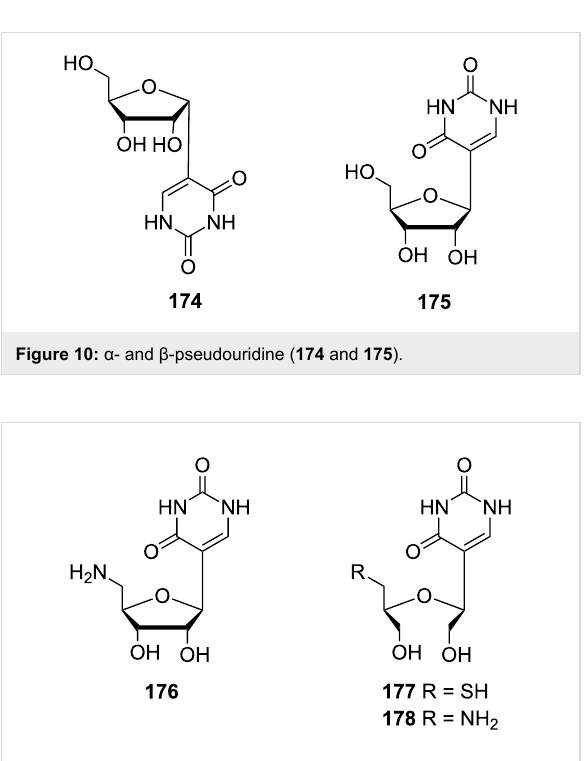
Figure 11: 5'-Modified pseudouridine 176 and secopseudouridines 177 , 178 .